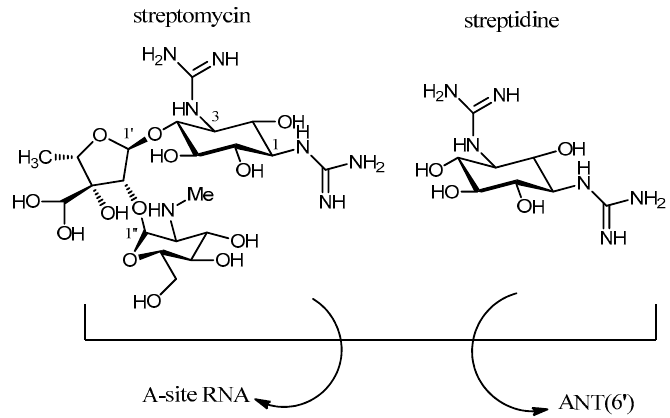
Figure 15. Structure of the streptomycin and streptidine as “decoy acceptor”.